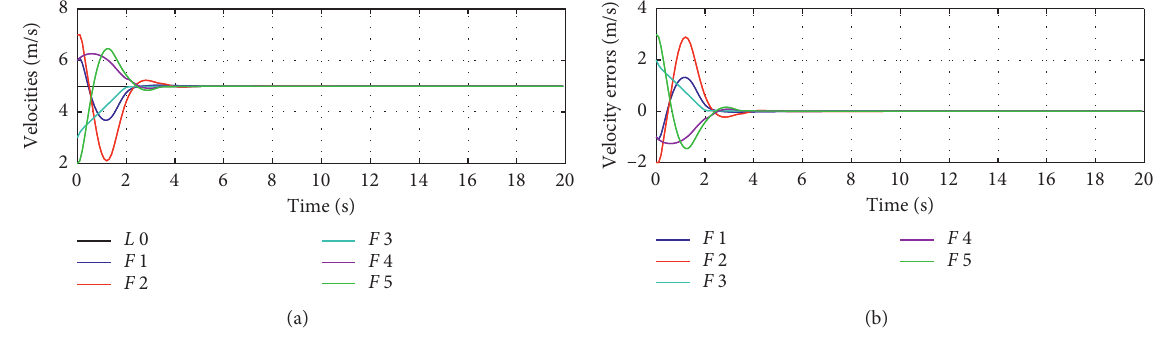
Figure 3: Velocities and velocity errors of the vehicles.